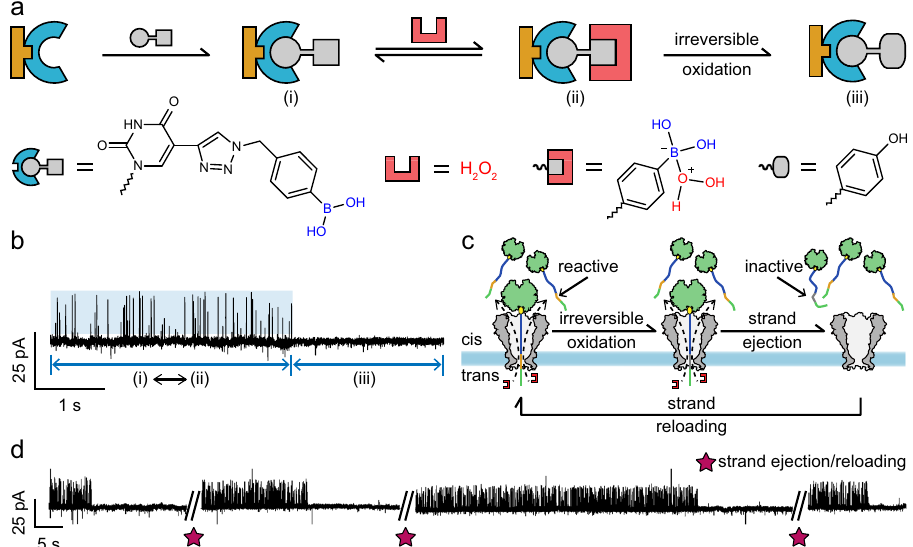
Fig. 4 Repetitive PNRSS measurement of irreversible reactions. a Introduction of PBA and the corresponding reaction mechanism. A PBA is introduced by CuAAC as described in Supplementary Figs. 18 – 20. The PBA on the PNRSS strand serves as the fi xed reactant. Hydrogen peroxide, acting as a mobile reactant, may either reversibly bind to PBA or irreversibly oxidize the PBA to a phenol. b A trace containing the reversible (i – ii) and irreversible (iii) reactions of a PBA. c The PNRSS strategy to cope with irreversible reactions. Upon irreversible oxidation, the docked PNRSS strand is voltage ejected and reloaded to initiate a new measurement cycle. d A trace containing repetitive PNRSS measurement. Four consecutive cycles of measurements are demonstrated. The star label marks the moment when the voltage ejection and reloading was performed (Supplementary Movie